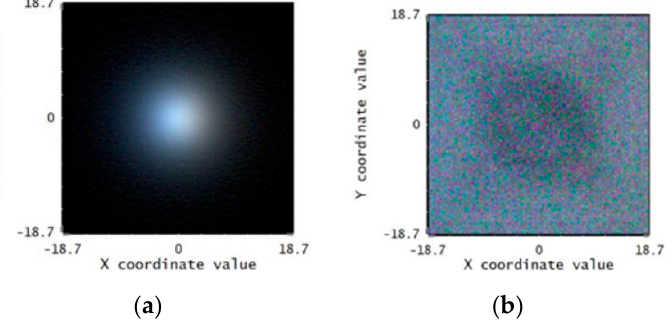
Figure 8. The simulation results of ( a ) only three-colors of LED light sources and ( b ) three-colors of LED light sources covered with our system. Table 1. The comparison of lighting uniformity between bare LEDs and our design. Bare